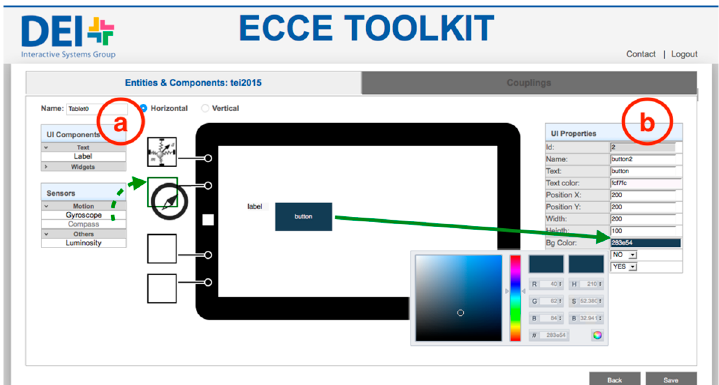
Figure 4. A screenshot of the web interface for editing off-the-shelf devices with a display screen. User can ( a ) add sensors and interface elements from a palette, and ( b ) configure the properties of digital elements on the screen.